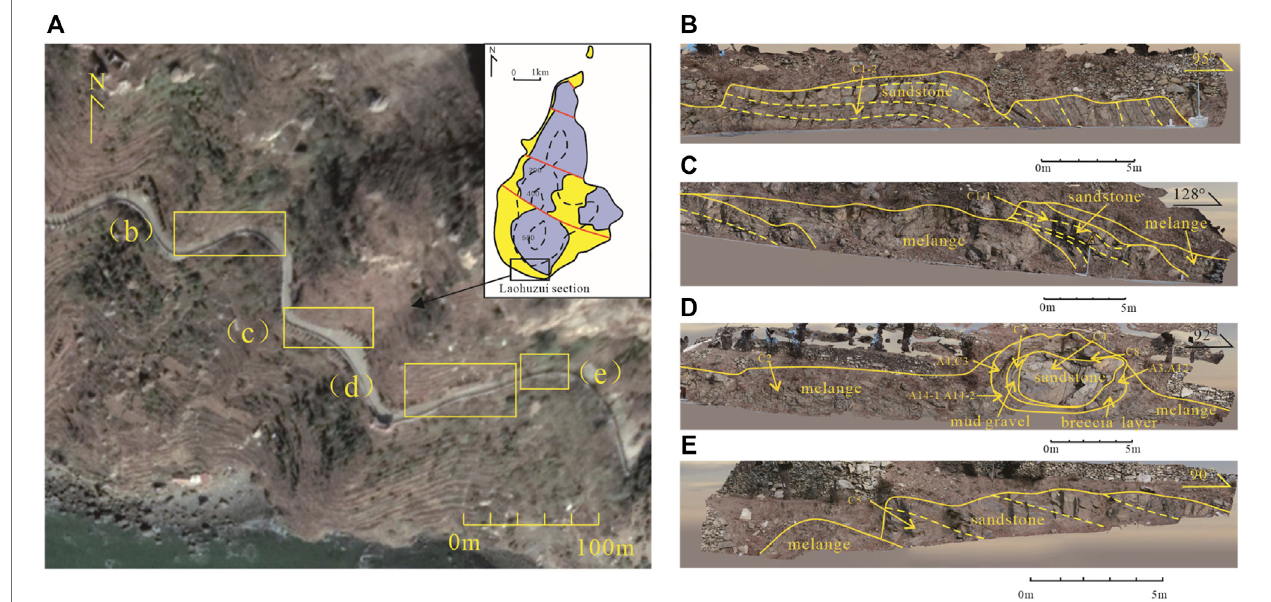
FIGURE 3 | Distribution of the Laohuzui section and sampling sites. (A) The location of a laser radar 3D model and photo image from Google Earth, (B) stratum is stillrelatively fl atatthewestern-mostsideoftheLaohuzuisection, (C) themelangehavebeenwelldevelopedinthemiddleoftheLaohuzuisection, (D) theeasternpartof the Laohuzui section is entirely composed of melange, a large olistolite with sandstone block developed within, and (E) the stratum is restored to fl at interbedded sand and mudstone at the eastern-most side of the Laohuzui section.